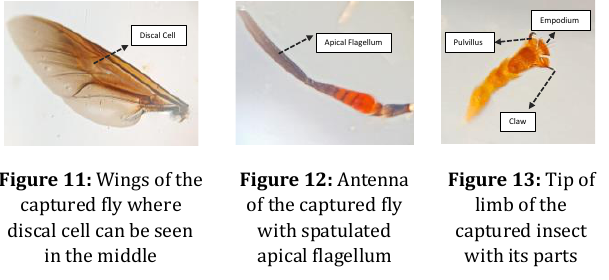
Figure 13: Tip of limb of the captured insect with its parts